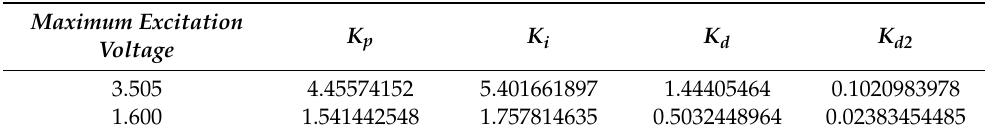
Figure 11. Excitation voltage response. Table 7. The optimal values of PIDD2 controller parameters obtained using the proposed method (SA–GTO).